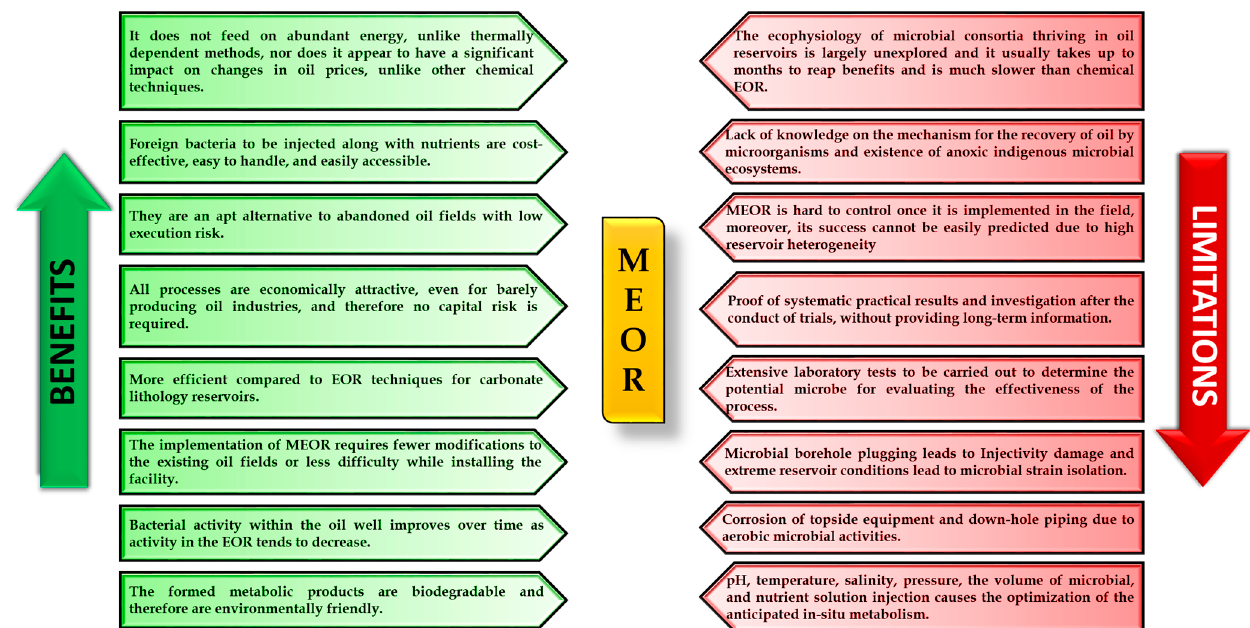
Figure 7. List of benefits and limitations of employing MEOR.